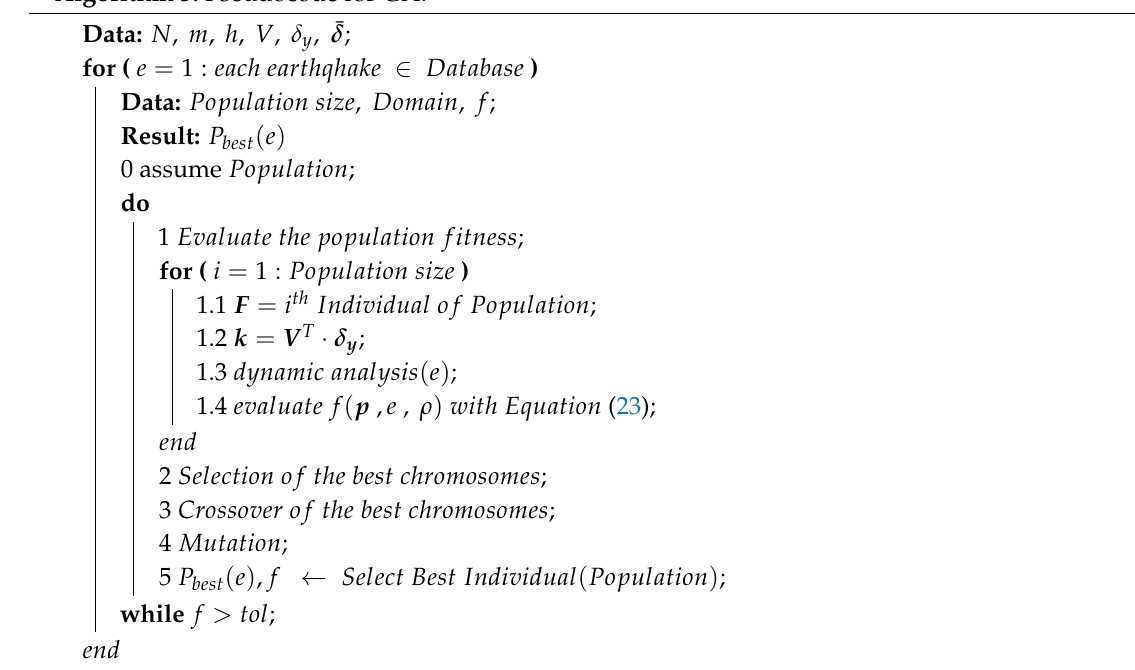
Algorithm 3: Pseudocode for